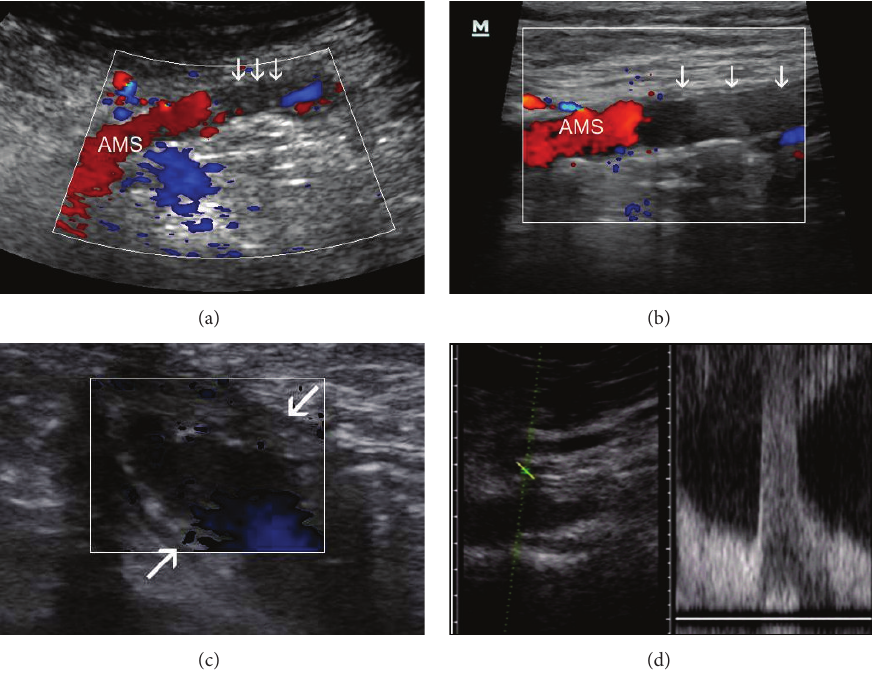
Figure 6: Vascular diseases of SB. (a) Fatal Thromboembolia of SMA in a patient with atrial fibrillation, with standard abdominal probe — absence of colour signal in embolised segment (arrows). (b) Use of high resolution probe in the same case. (c) Transversal view of jejunal loop without peristalsis, with thickened, avascular wall—another patient with SMA thromboembolia—but with presence of flow in proximal segment of SMA. High resolution probe. (e) Significant stenosis of SMA/Vmax over 400 cm/sek ( > 70%) in a patient with ischemic colitis. Standard